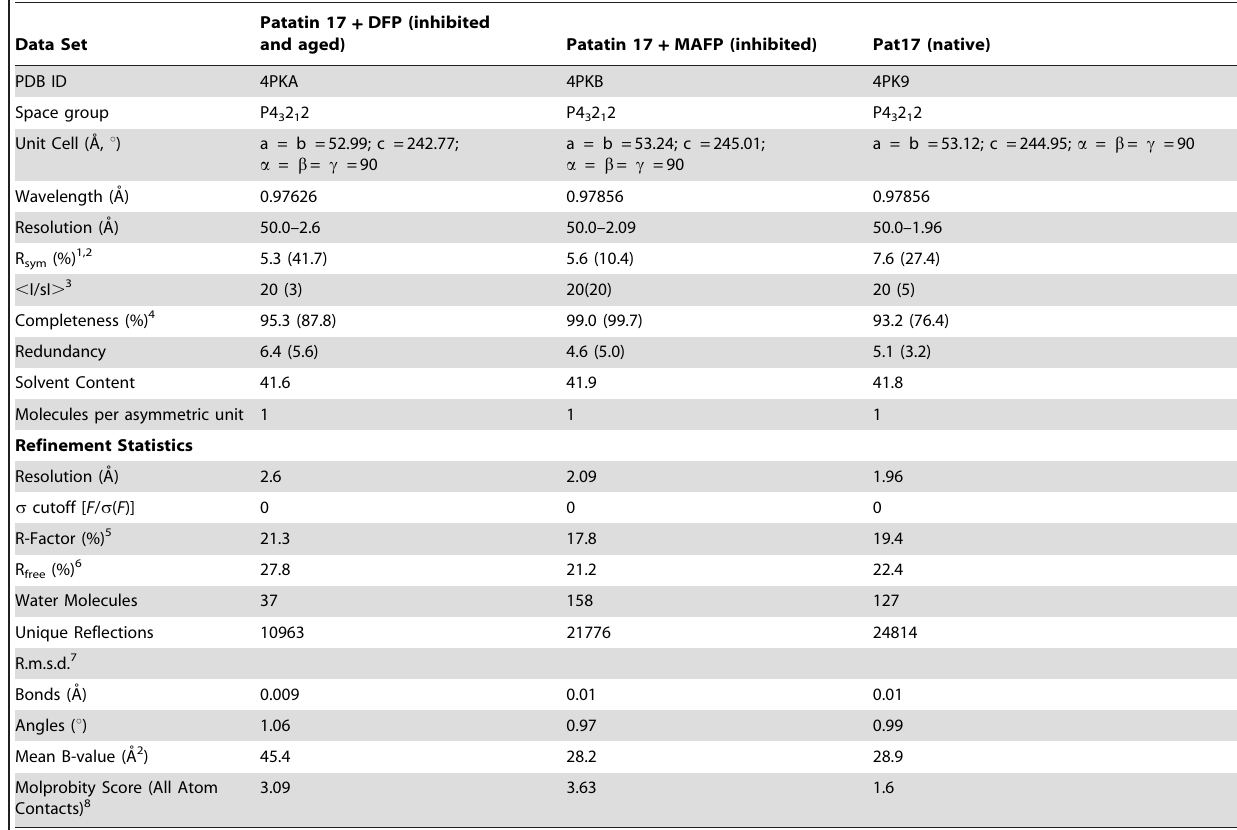
Table 2. Crystallography Data Collection and Refinement Statistics.